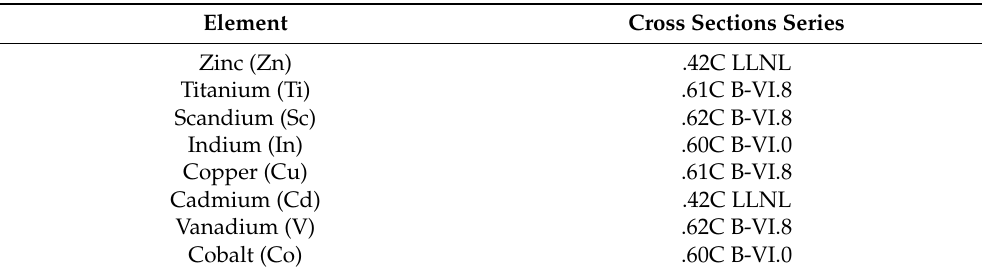
chosen for each substance.